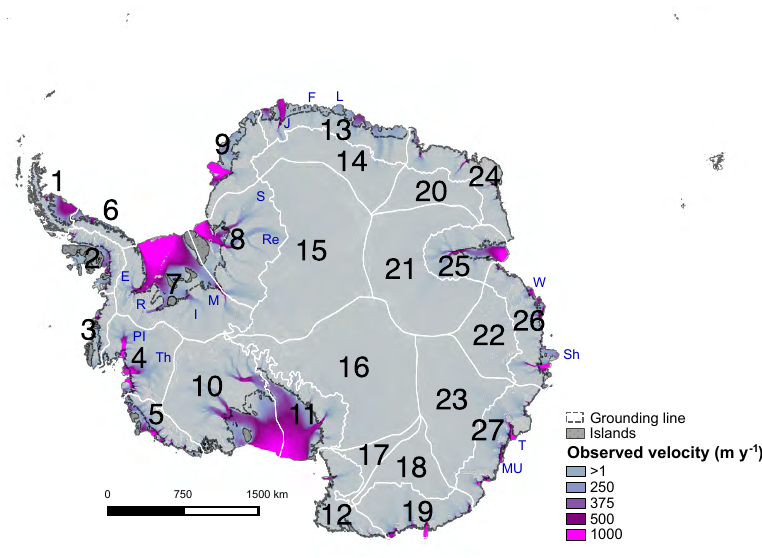
Figure 1. Observed surface velocity (myr − 1 ) in Antarctica, with geographic partitions in white, labeled with their corresponding numerical value (1–27). We indicate the observed grounding line with a dark gray dashed line and additional features of interest in blue: Th – Thwaites Glacier; PI – Pine Island Glacier; E – Evans Ice Stream; R – Rutford Ice Stream; I – Institute Ice Stream; M – Möller Ice Stream; Re – Recovery Ice Stream; S – Slessor Ice Stream; J – Jutulstraumen Glacier; F – Fimbul Ice Shelf; L – Lazarev Ice Shelf; W – West Ice Shelf; Sh – Shackleton Ice Shelf; T – Totten Glacier; MU – Moscow University Ice